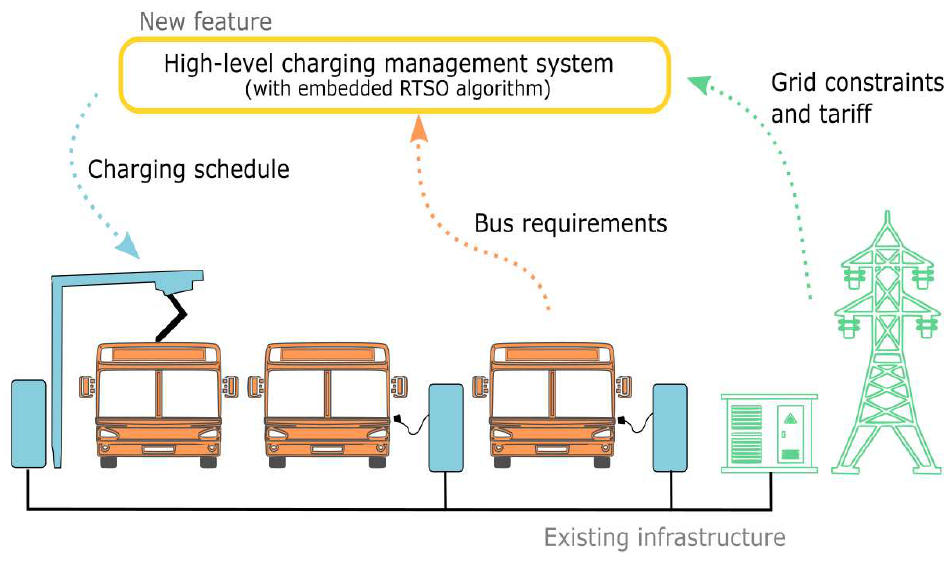
Figure 1. BEB depot charging architecture with